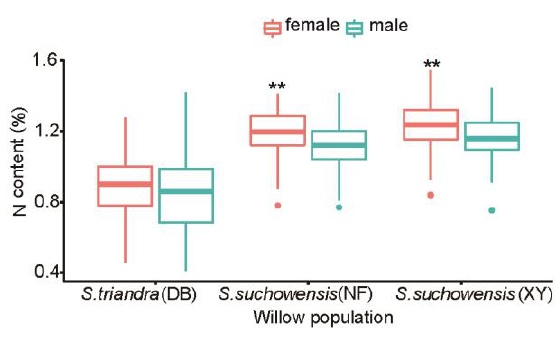
Figure 3. Contents of N in leaves of willow plants. Notes: Comparisons between females and males within leaf N content (N) were performed using the pairwise t-test. ** p < 0.01. Filled dots represent outliers.